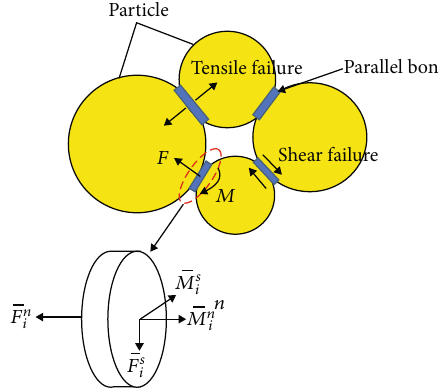
Figure 2: Mechanical mechanism of parallel bond model [28].